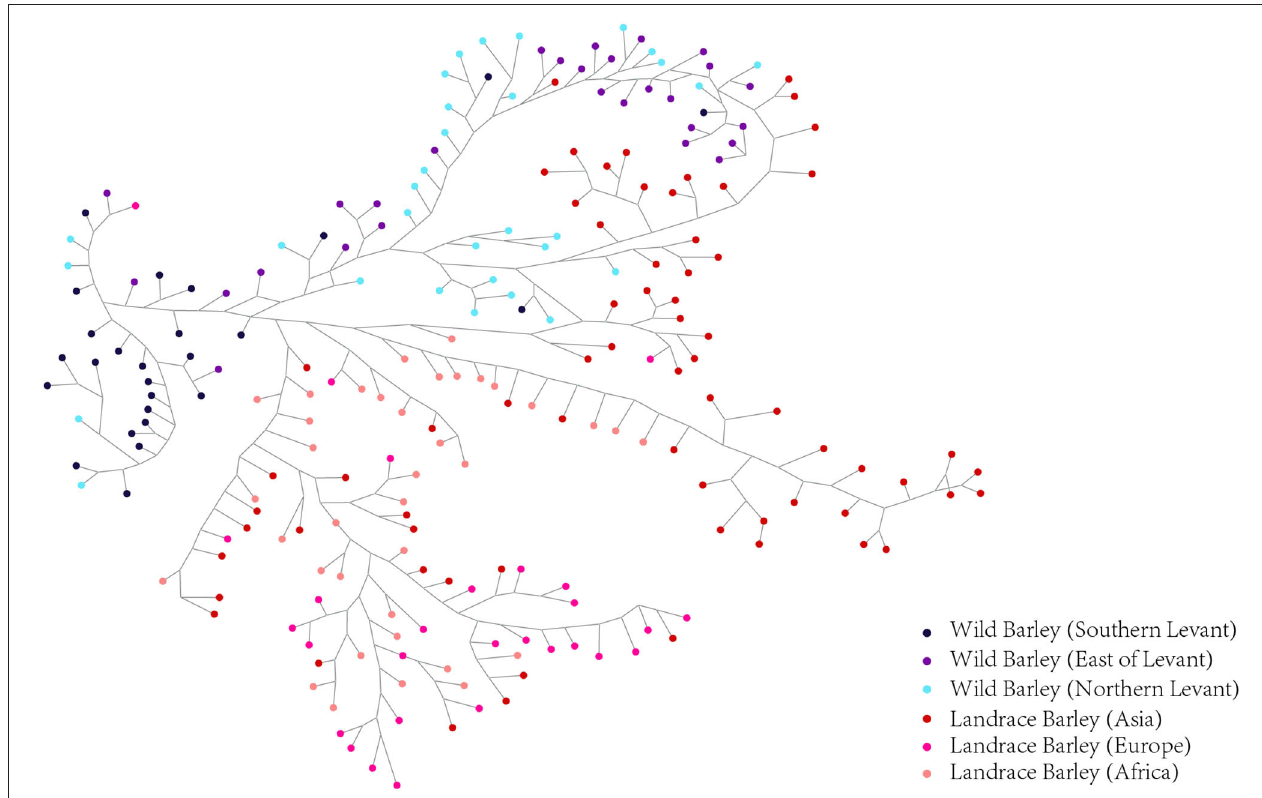
FIGURE 9 | Median-Joining network analysis of wild barley accessions and landraces based on HvmTERF -related SNPs. Wild barley accessions were divided into Southern Levant, Northern Levant, and East of Levant groups. Landraces were divided into Asia, Europe, and Africa groups.